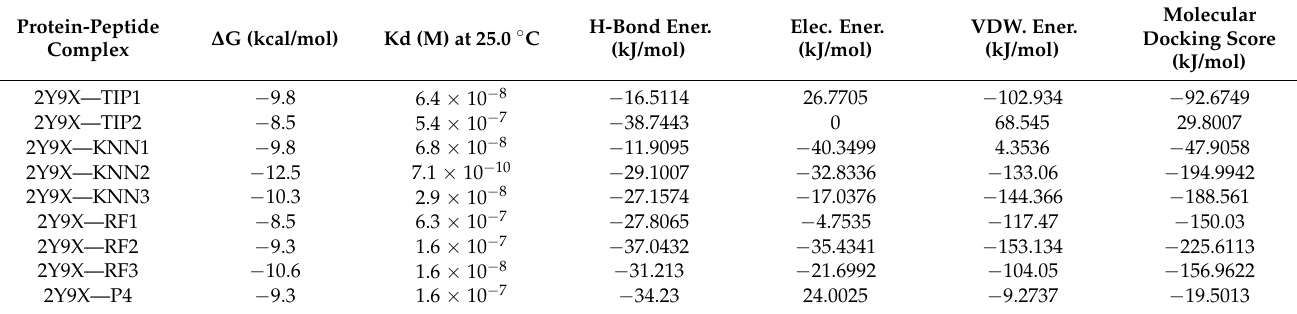
Table 2. Calculated binding affinity ( ∆ G), dissociation constant (Kd), and binding energy scores from the molecular docking results from HPEPDOCK of peptides to the tyrosinase based on the PROGIDY and PIMA web servers.